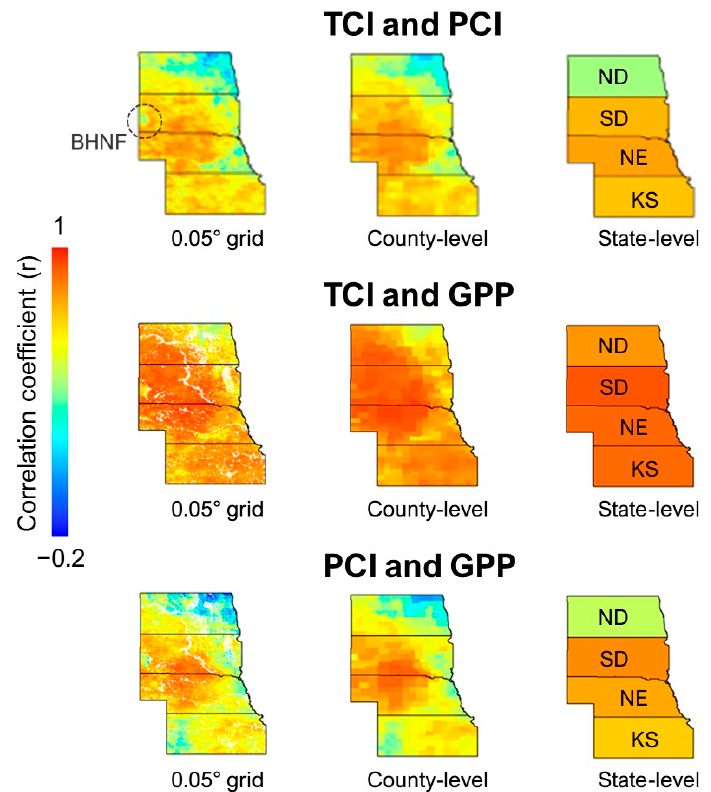
Figure 3. Detailed correlation analysis of annual variation between TCI and PCI, TCI and GPP, and PCI and GPP for pixel-level, county-level, and state-level 0.05° grids for the average of July and August over North Dakota (ND), South Dakota (SD), Nebraska (NE), and Kansas (KS). The dotted circle line represents the region of Black Hills National Forest (BHNF).